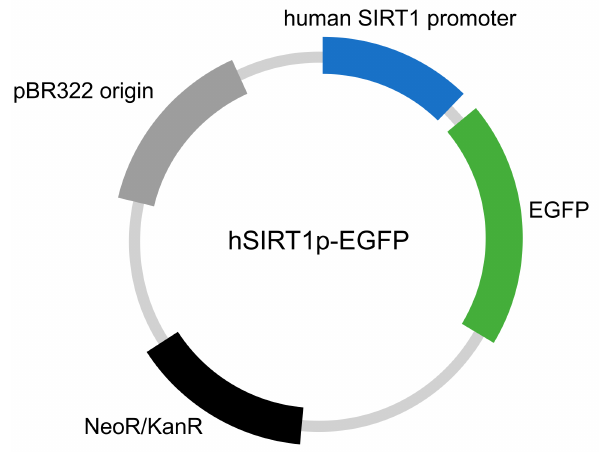
Figure 7. SIRT1 promoter reporter